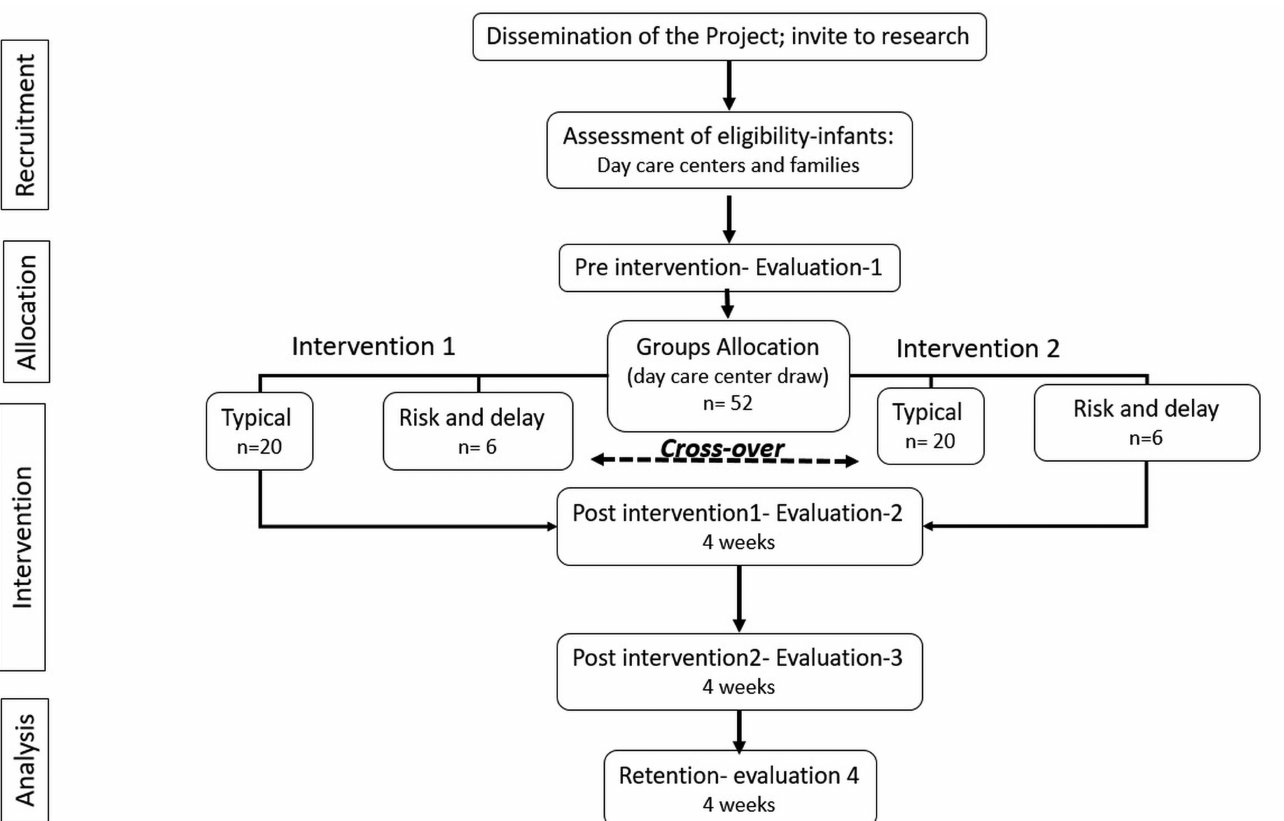
Figure 1. Flow diagram of the